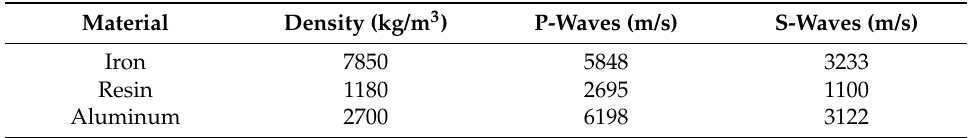
Table 4. Density of the different materials.